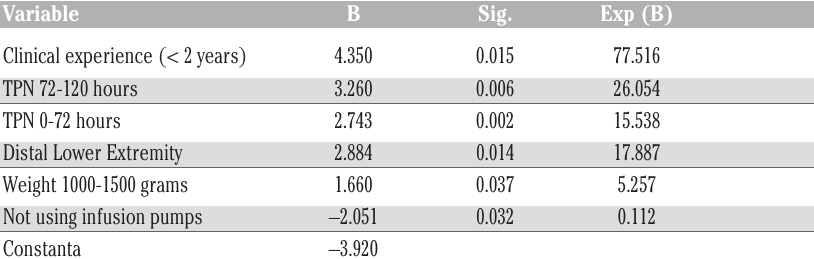
Table 2. Multivariate analysis with backward method between selected independent vari- ables and phlebitis incidences (n = 106).